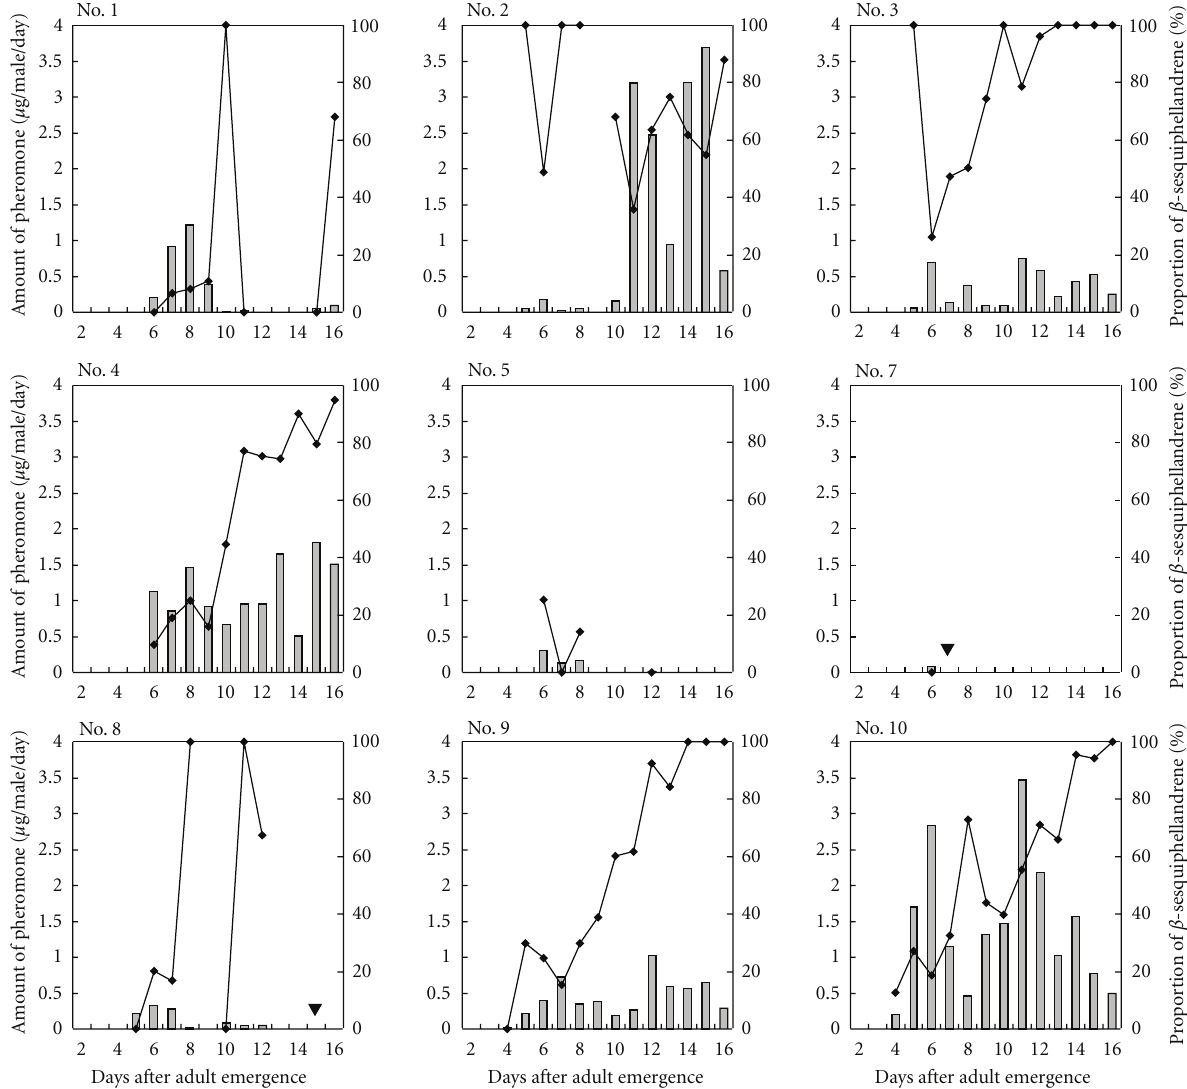
Figure 1: Daily changes in pheromone emission and the proportion of β -sesquiphellandrene from individual males of Piezodorus hybneri . The bar shows the total amount of pheromone ( μ g/male/day). The line chart indicates the proportion of β -sesquiphellandrene (%) among the total pheromone components. Inverted triangle indicates the day when the bugs died. Because male No. 6 did not emit any pheromone, there was no data available in this